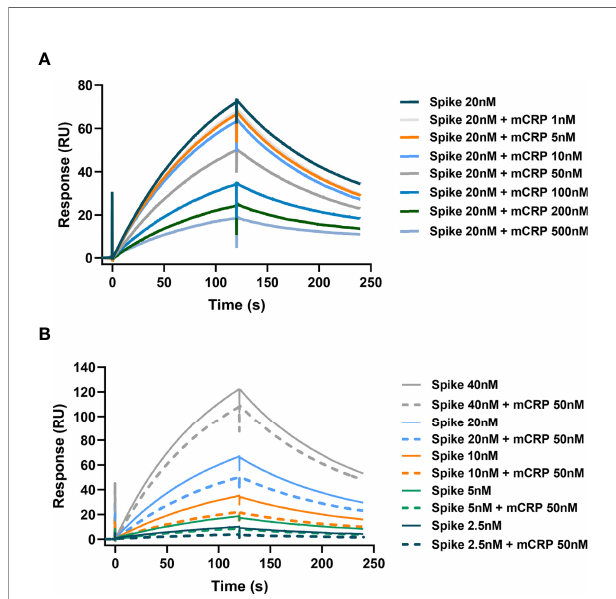
FIGURE 2 | mCRP competitively inhibits the binding of the spike RBD to ACE2. (A) mCRP competes for the binding of spike RBD to ACE2 in a concentration- dependent manner. In the surface plasmon resonance (SPR) binding assay, different concentrations of mCRP were added to compete for the binding of the spike RBD to ACE2. Results showed that mCRP competed for the binding of the spike RBD to ACE2 in a concentration-dependent manner. (B) A fi xed concentration of mCRP competes with the binding of different concentrations of the spike RBD to ACE2. For detecting the binding of different concentrations of the spike RBD to ACE2 (solid line), a fi xed concentration of mCRP was added to compete for binding (dotted line), and mCRP competitively inhibited the binding of the spike RBD to